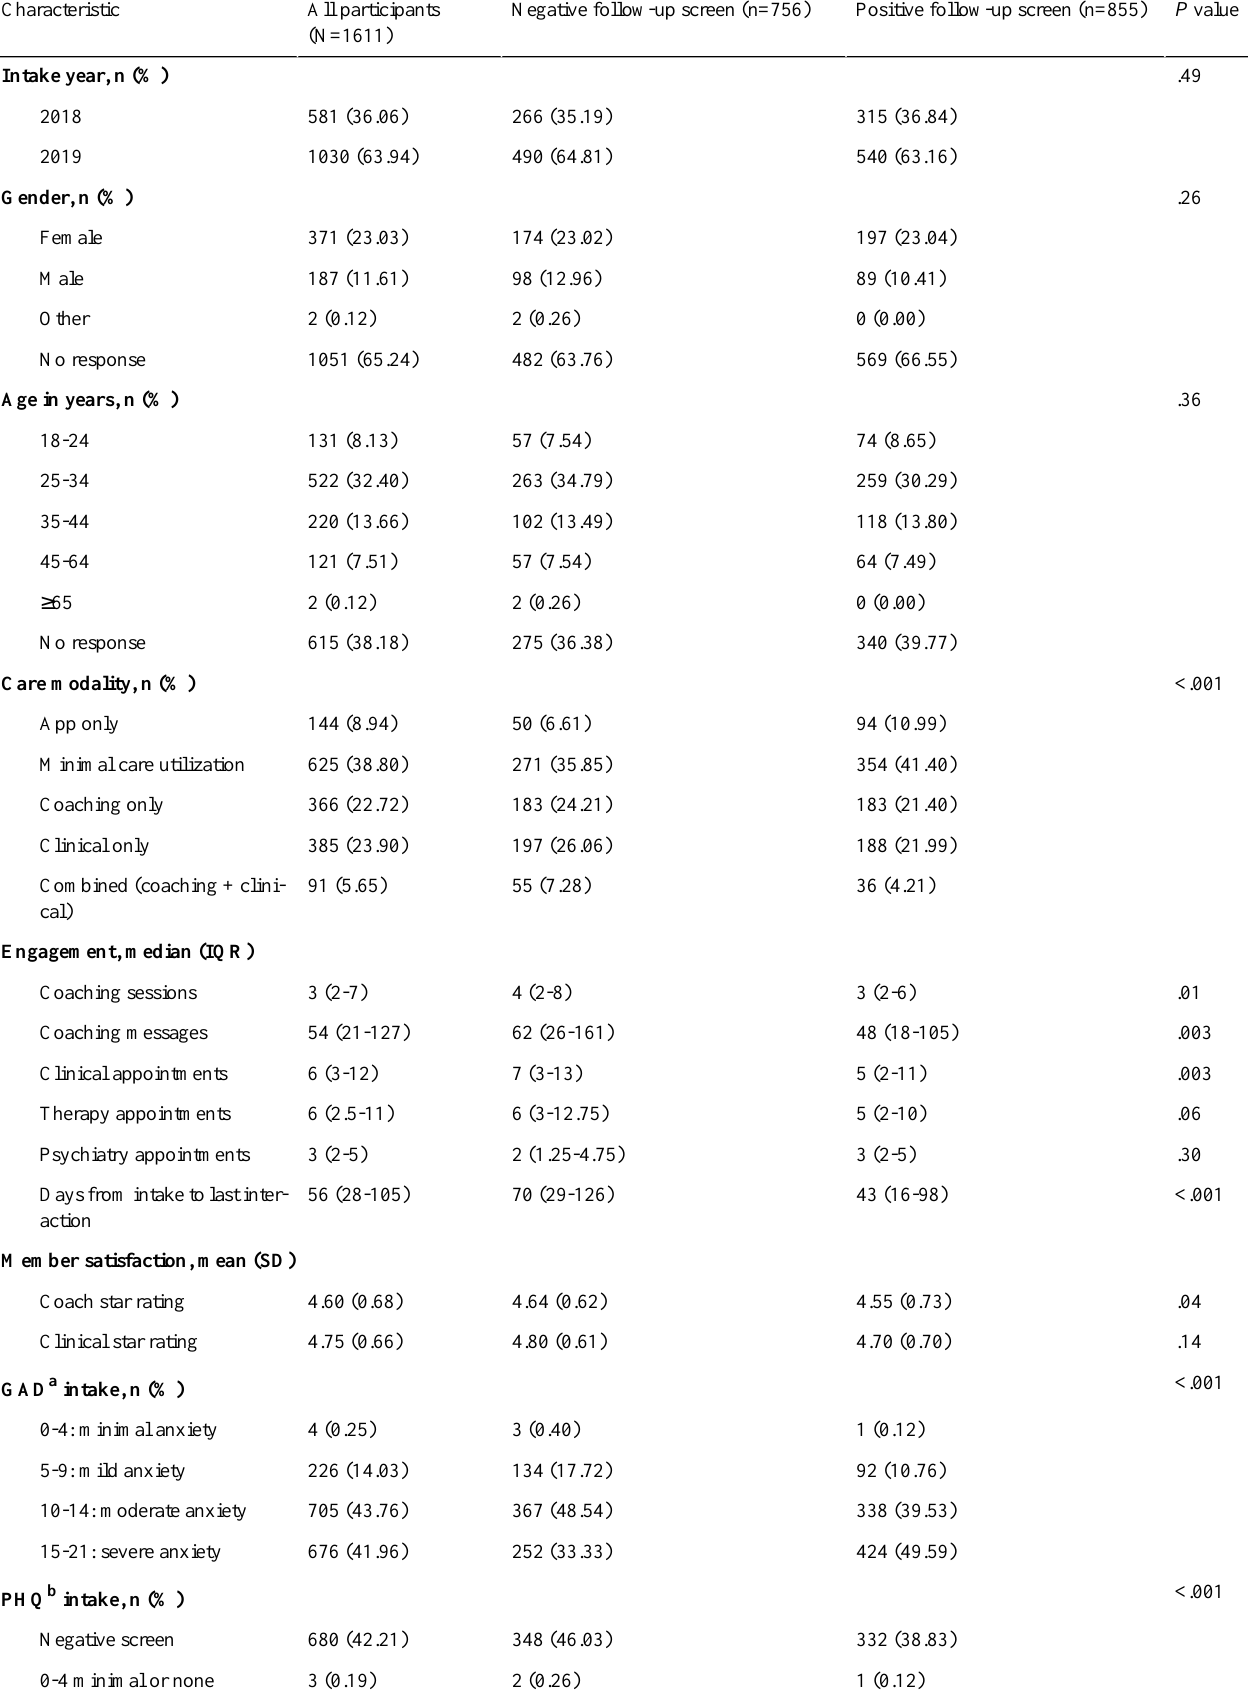
Table 2. Characteristics of the study cohort